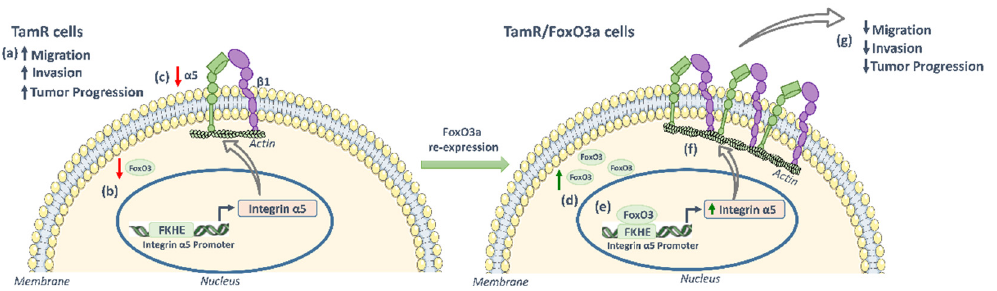
Figure 6. FoxO3a inhibits TamR cells progression by inducing integrin α 5 expression . Compared to tamoxifen responsive MCF-7, TamR cells (a) show higher tumor progression-associated features and express reduced levels of both (b) FoxO3a and (c) integrin α 5. FoxO3a re-expression